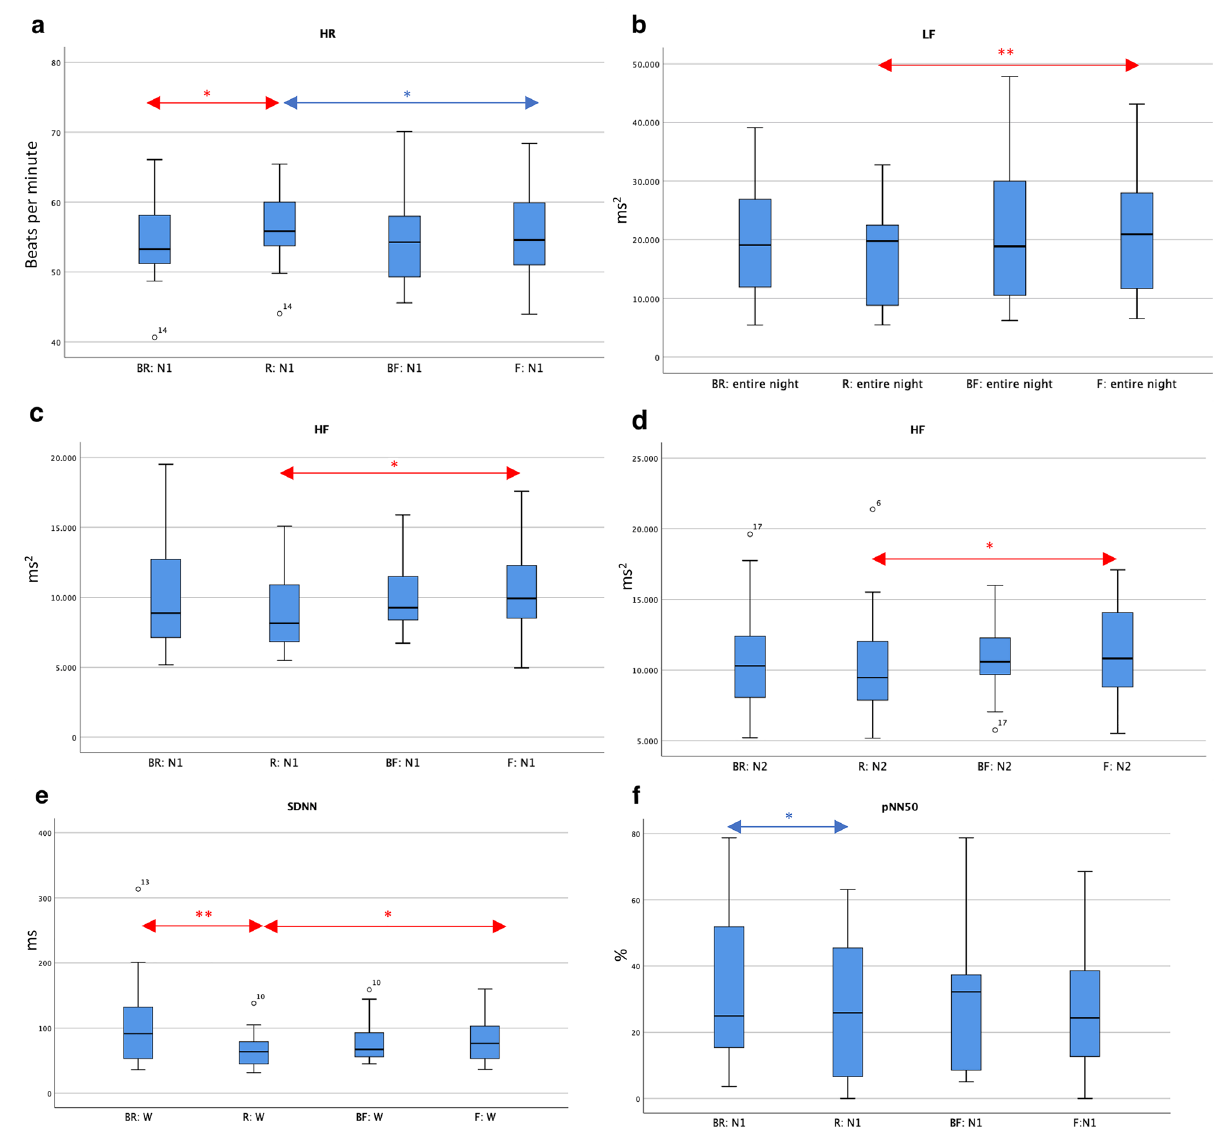
Figure 2. Presentation of significant differences in HR (heart rate) and HRV (heart rate variability) parameters between nights and in specific sleep stages. Presented are medians and interquartile range. The x-axis represents the nights ( BR baseline night before restriction night, R restriction night, BF baseline night before fragmentation night, F fragmentation night) and the sleep stages (N1, N2 = Low sleep stages 1 and 2, W = wake-periods during night). The y-axis represents the value for the respective parameters ( a ) HR (heart rate) [beats per minute], ( b ) LF (low-frequency-band) [ms 2 ], ( c ) HF in N1 (high-frequency-band) [ms 2 ], ( d ) HF in N2 [ms 2 ] ( e ) SDNN (standard deviation of NN-intervals) [ms], ( f ) pNN50 (proportion of number of interval differences of successive heart beats greater than 50 ms) [%]. Post-hoc Wilcoxon-Test was applied as a part of Friedman- Test, comparing the four nights. Red arrows show the significant differences with Bonferroni-correction for familywise errors, blue arrows show the significant differences without Bonferroni-correction. Significance levels are set at p < 0.05*, and p < 0.01**. Significant differences between an intervention night and the not- corresponding baseline night (e.g., F and BR) are not